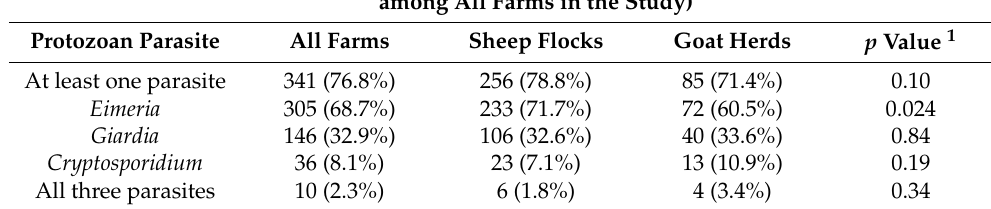
Table 1. Presence of protozoan parasites in pooled faecal samples from 444 small ruminant farms in a countrywide investigation (April 2019 to July 2020) in Greece. Number of Farms with Samples in Which Protozoan Parasites Were Detected (Proportion of These Farms among All Farms in the Study) Protozoan Parasite All Farms Sheep Flocks Goat Herds